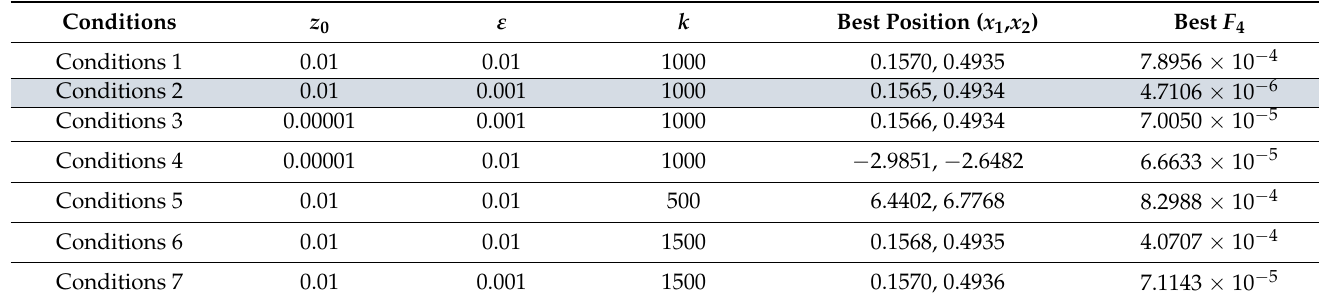
Table 7. Results of Case 4: F 4 at different conditions.